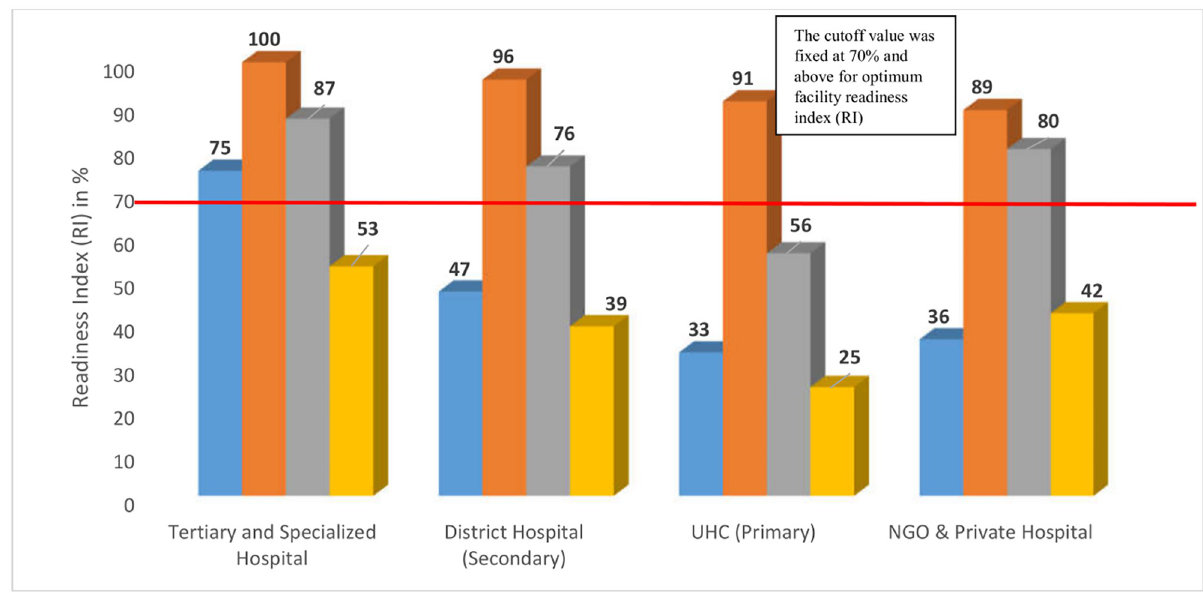
Fig 2. Domain specific DM service readiness index stratified by facility level (the red line indicates the cut off value 70%, above which a hospital is considered to be ’ready’ to provide DM services).